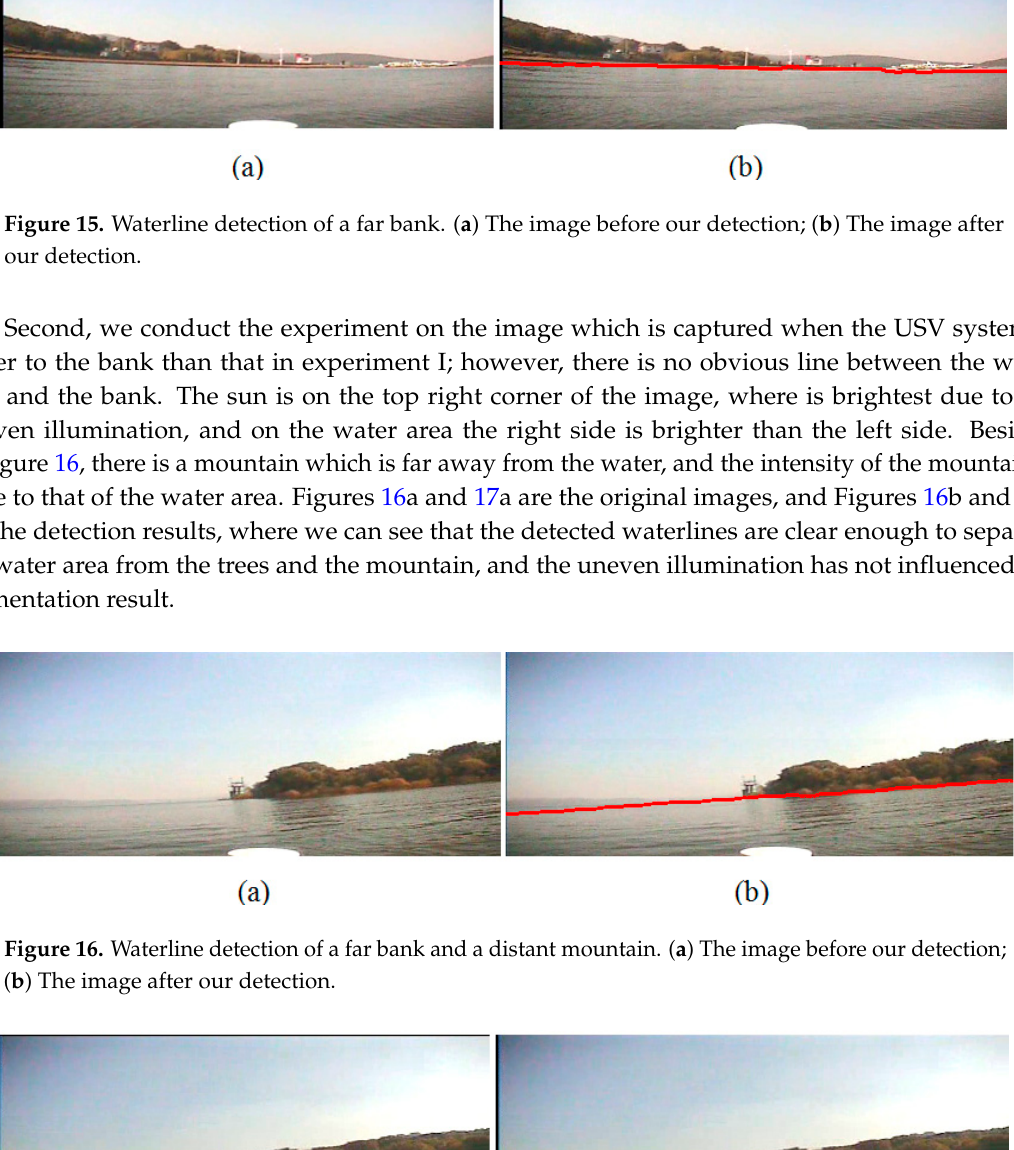
Figure 17. Waterline detection of a closer bank with uneven illumination. ( a ) The image before our detection; ( b ) The image after our detection.